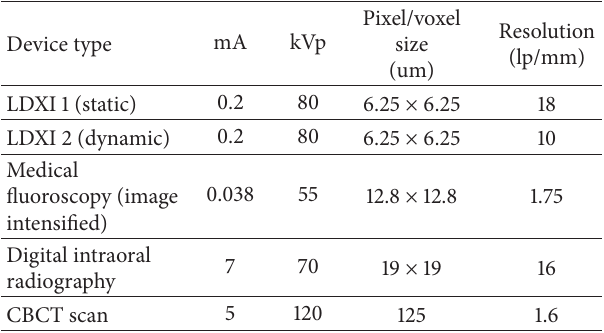
Table 1: mA, kVp, pixel size settings, and resolution outcome comparison of different